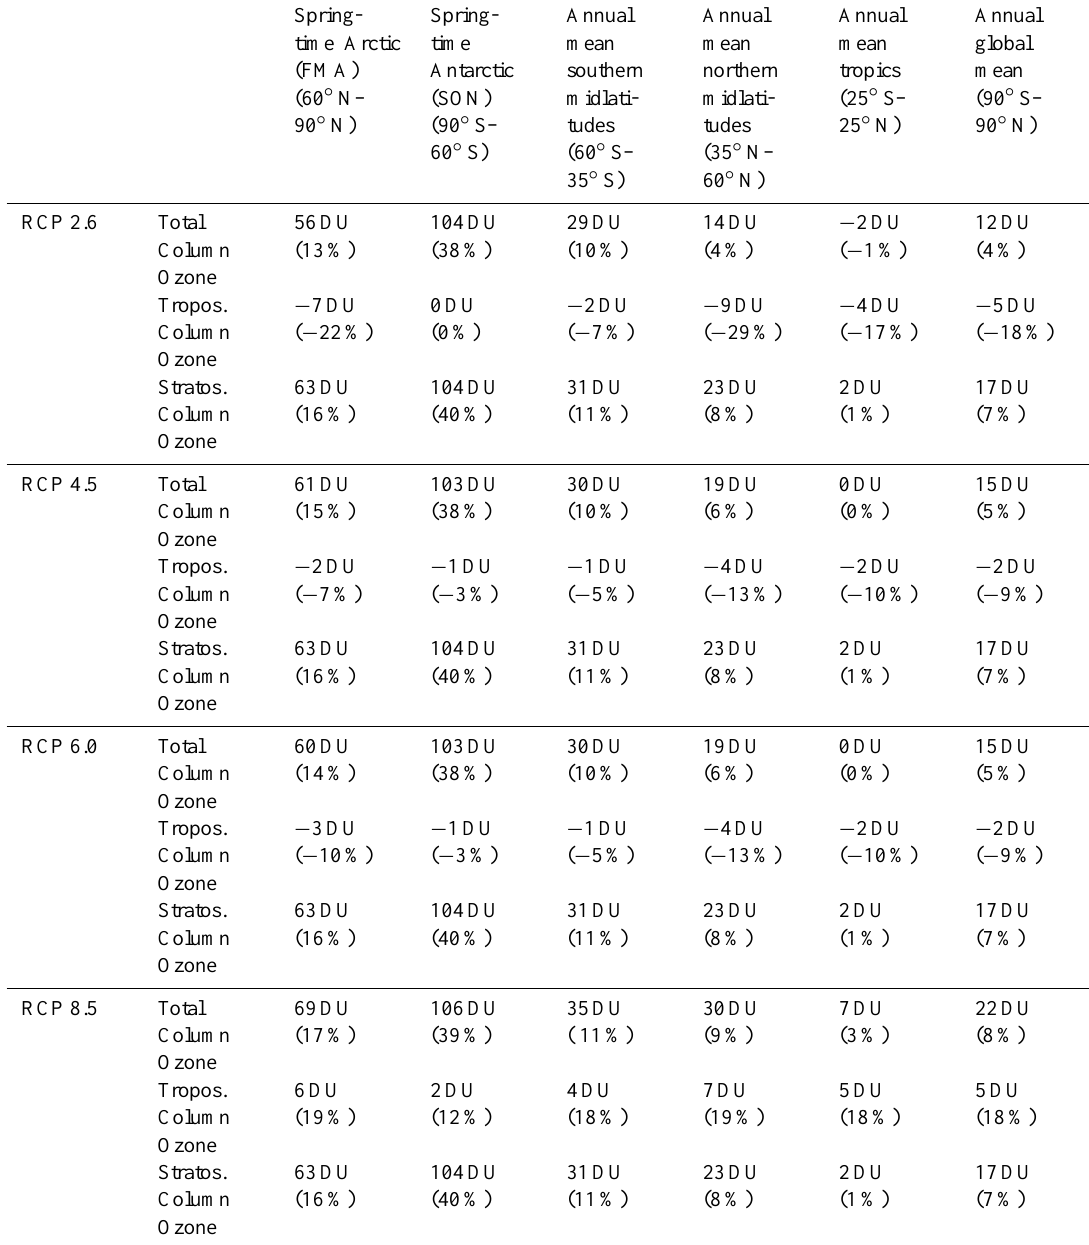
Table 4. Trends (2090s–2010s) in total and tropospheric column ozone in the four